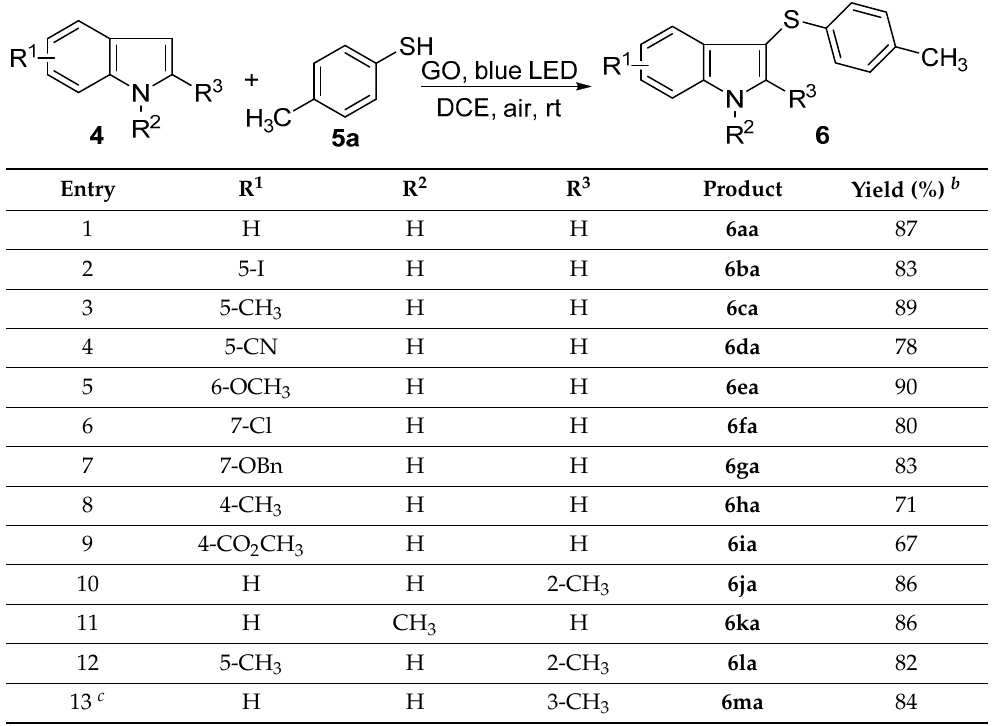
Table 2. Scope of indoles a .